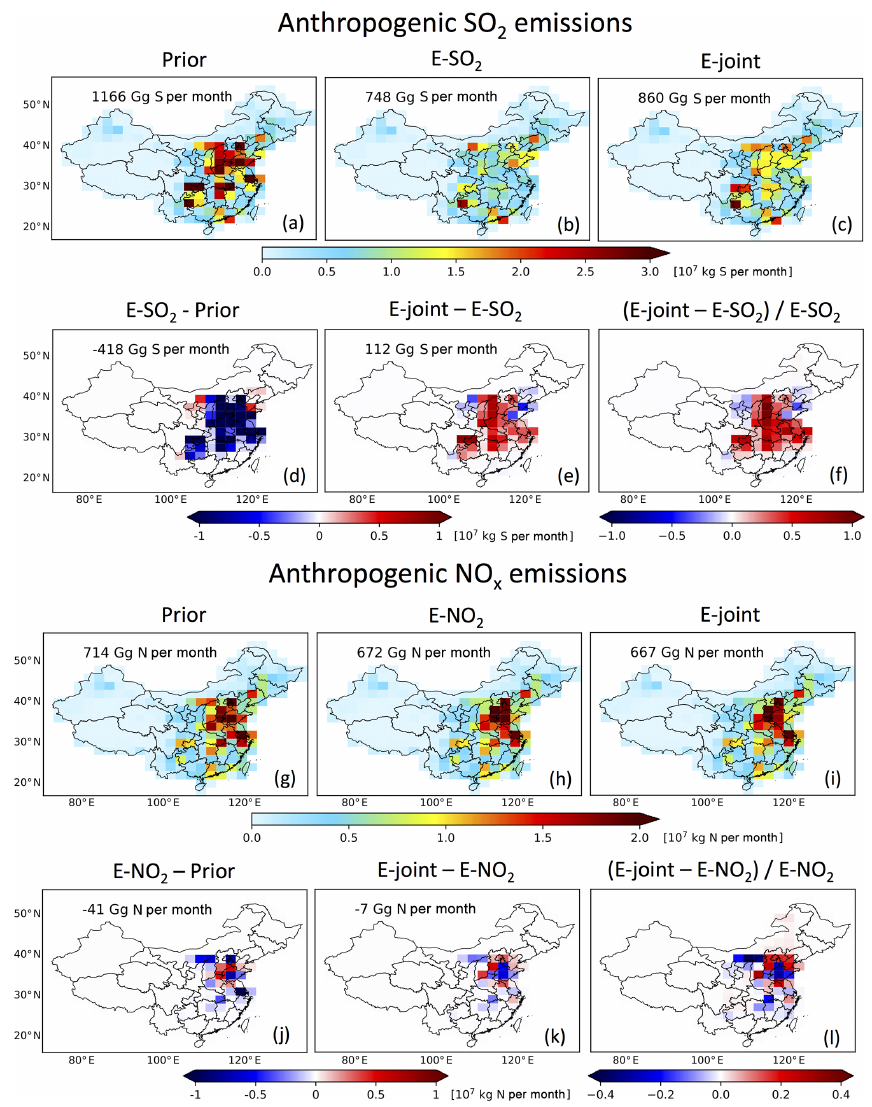
Figure 4. The top is anthropogenic SO 2 emissions from prior MIX 2010 (a) , posterior E − SO 2 (b) , posterior E-joint (c) , the difference between posterior E − SO 2 and prior MIX 2010 (d) , the difference between posterior E-joint and posterior E − SO 2 (e) , and the relative difference between posterior E-joint and posterior E − SO 2 (f) for October 2013. The bottom is similar to the top except that (1) it is for NO x and (2) E − SO 2 is replaced by E − NO 2